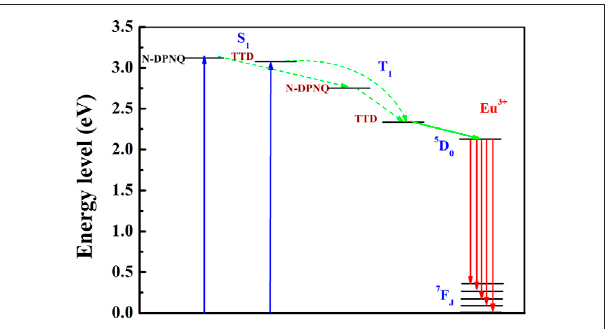
FIGURE 9 | Energy levels of ligands and Eu center in Eu (N-DPNQ) (TTD) 3